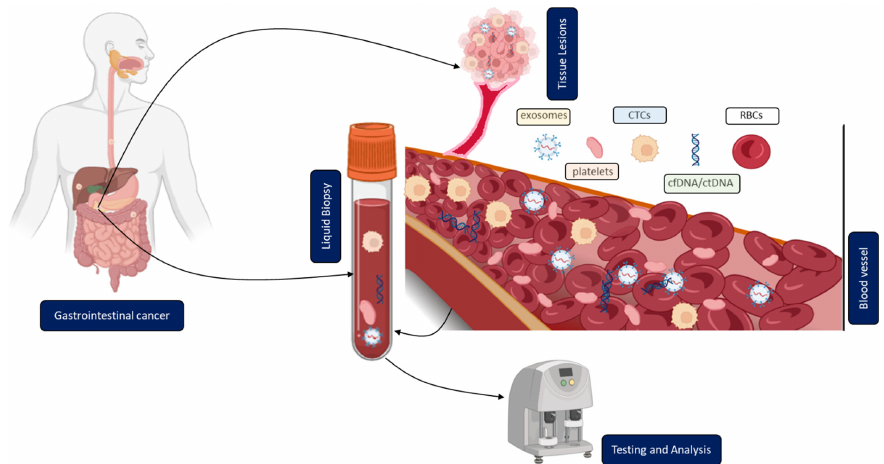
Figure 1. Clinical application of liquid biopsy (LB) in gastrointestinal cancer (GICs). Circulating tumor cells (CTCs), cell-free or circulating tumor DNA (cfDNA/ctDNA), tumor-educated platelets (TEP), exosomes, and RBCs in the blood of GICs patients can be used as potential biomarkers for LBs and their expression levels can be measured to determine the clinical status of GICs patients.